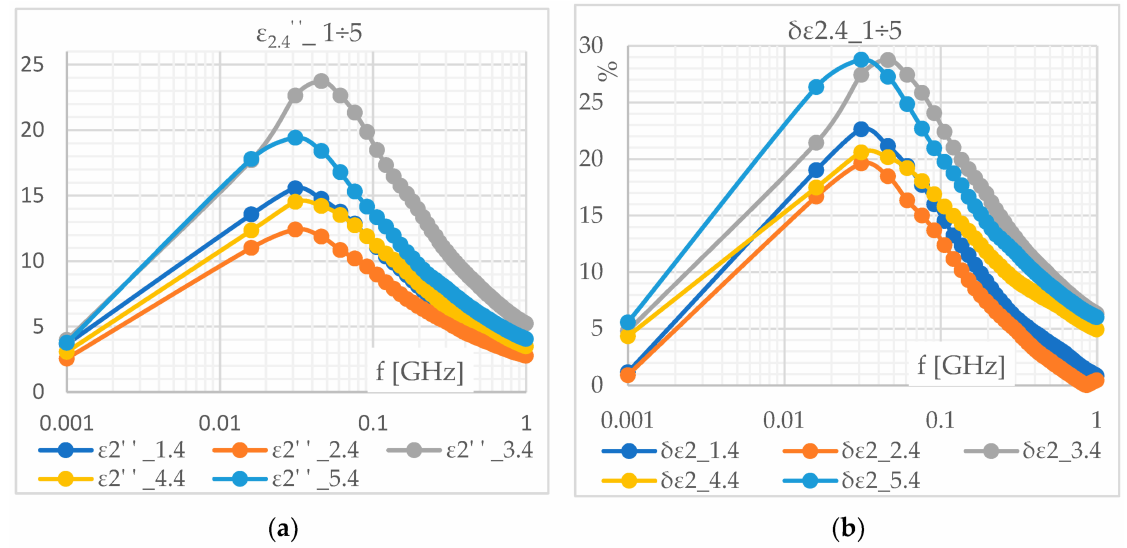
Figure 8. ( a ) The loss factor ε (cid:48)(cid:48) . 2.1